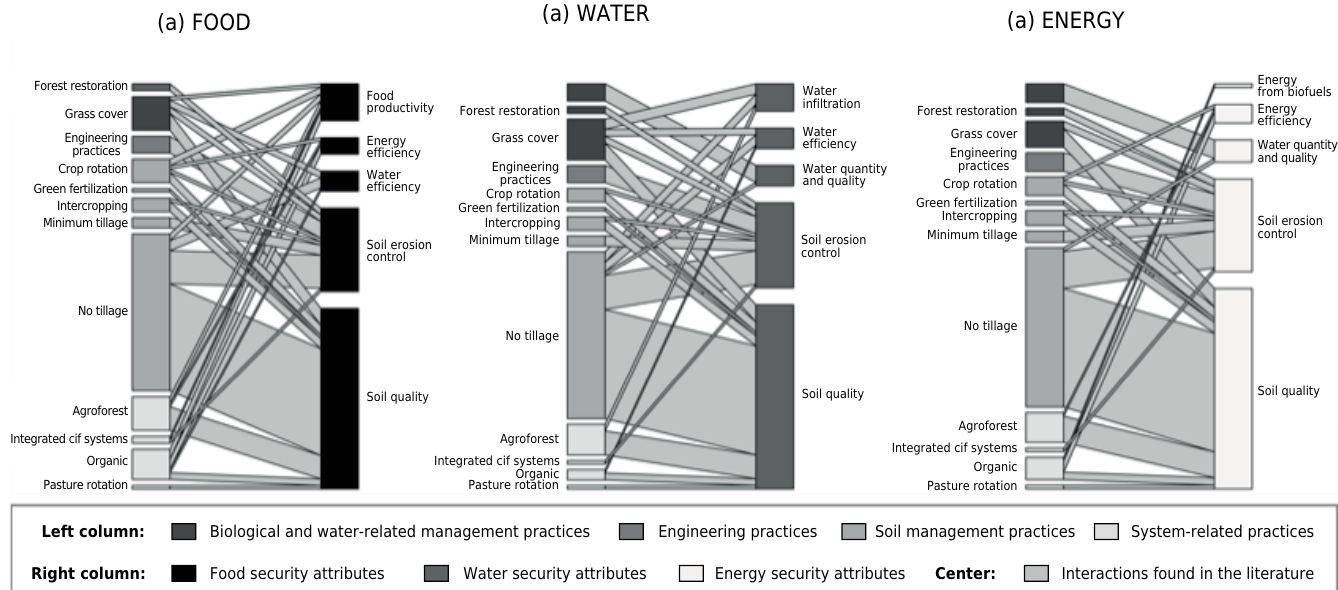
Figure 3. Linkages between rural practices (organized by groups; left column) and attributes of (a) food, (b) water and (c) energy security systems. The width of the links and bars represent the number of combinations identified in the literature.